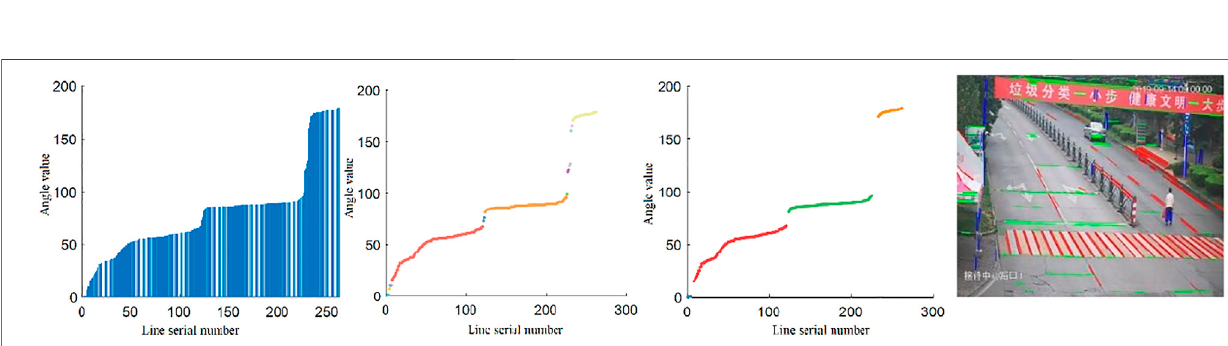
FIGURE 7 | Screening and classi fi cation results of cluster lines. (A) Cluster line screening results. (B) Line classi fi cation results.